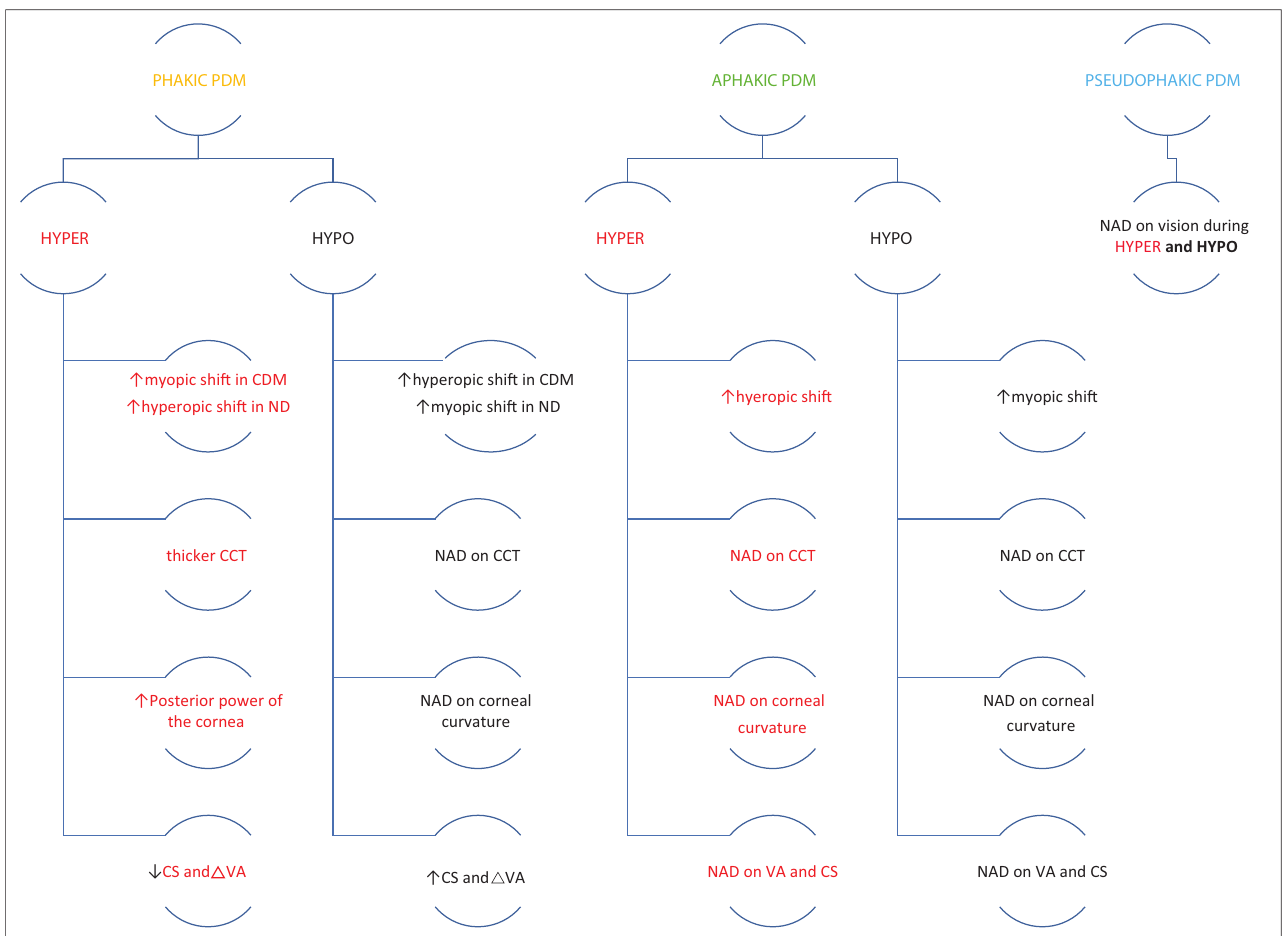
FIGURE 1: A schematic summary of the effects of glycaemic changes on vision in phakic, aphakic and pseudophakic people with diabetes